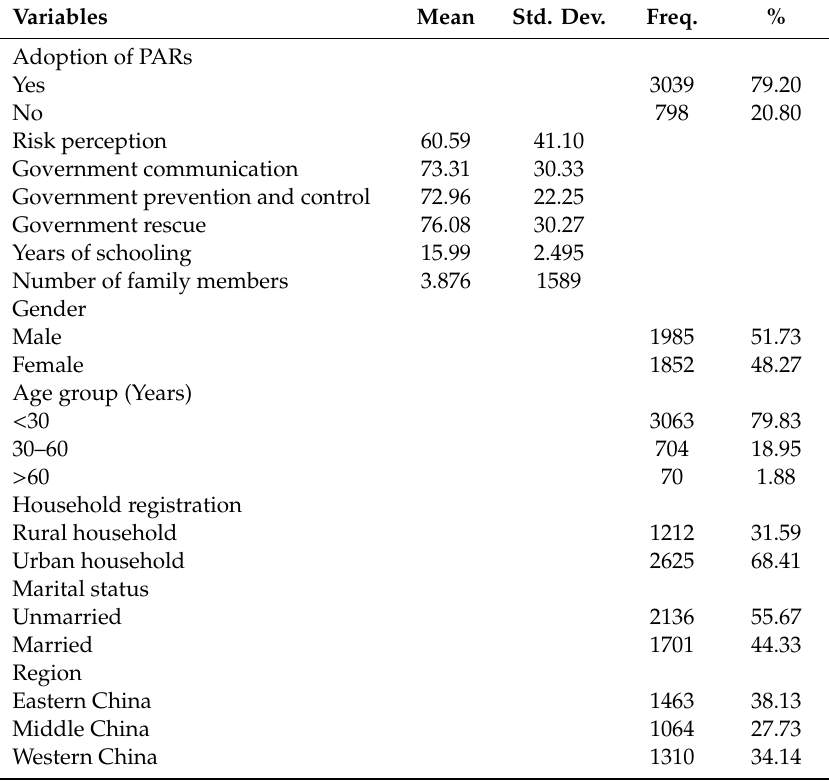
Table 2. Descriptive statistics for the main